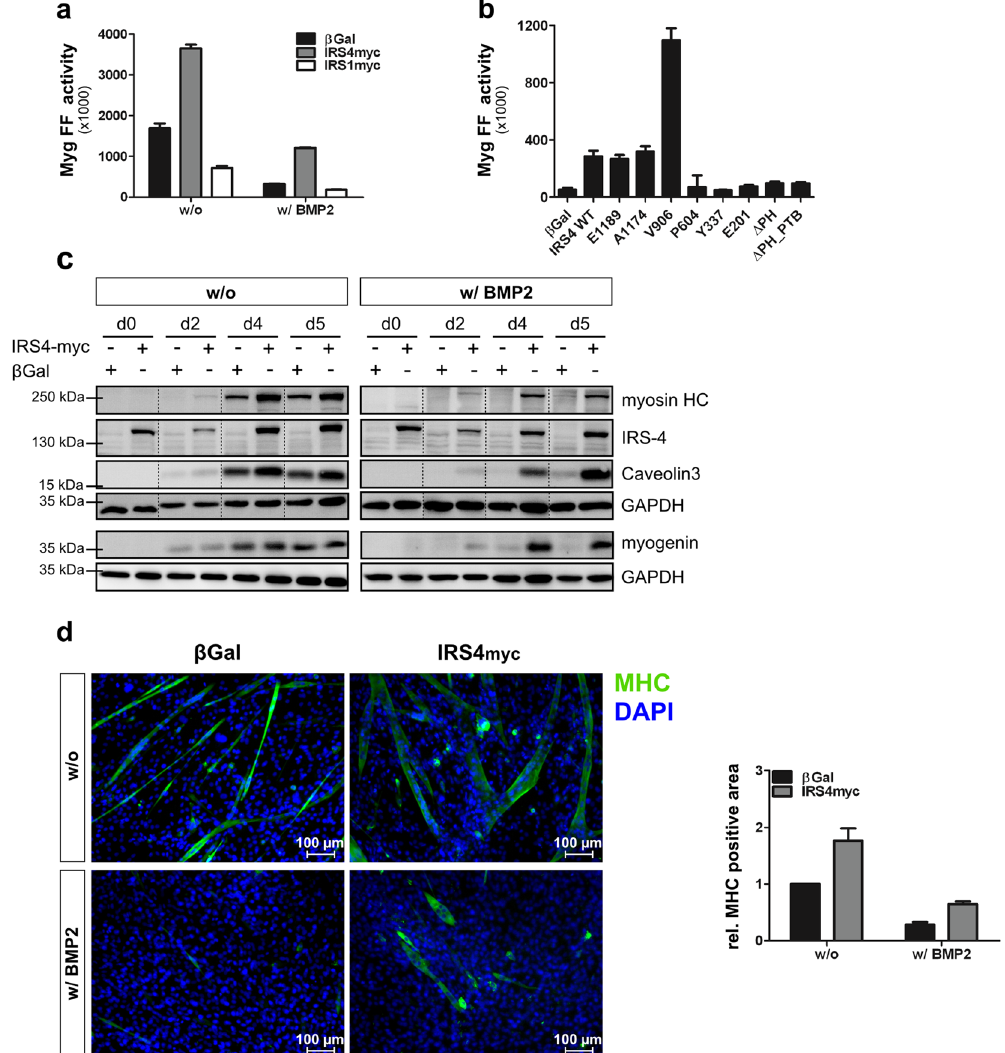
Figure 5. IRS4 enhances expression of myogenic markers and promotes myogenesis. ( a , b ) IRS4 but not IRS1 affects Myg-luc expression. C2C12 cells transfected with the Myg-luc reporter and indicated constructs were differentiated with or without 5 nM BMP2. Bar charts depict means ± SD of firefly luciferase activity from triplicate measurements representative for 3 independent experiments. ( c ) IRS4 enhances expression of myogenic markers. Transfected C2C12 cells were differentiated with or without 5 nM BMP2 for indicated times. Lysates were subjected to Western blotting using indicated antibodies. Dashed lines indicate the exclusion of irrelevant lanes from the same membrane ( d ) IRS4 triggers myogenesis. Transfected C2C12 cells were differentiated with or without 5 nM BMP2. Myosin heavy chain (MHC) was stained using a specific antibody; nuclei were stained using DAPI. Images were quantified using ImageJ. Bar chart depicts means ± SD of at least 60 images per condition derived from 4 independent experiments. To analyse different proteins in the same samples simultaneously, membranes were cut accordingly and incubated with respective antibodies separately. For a clear and concise data presentation, displayed blots were cropped